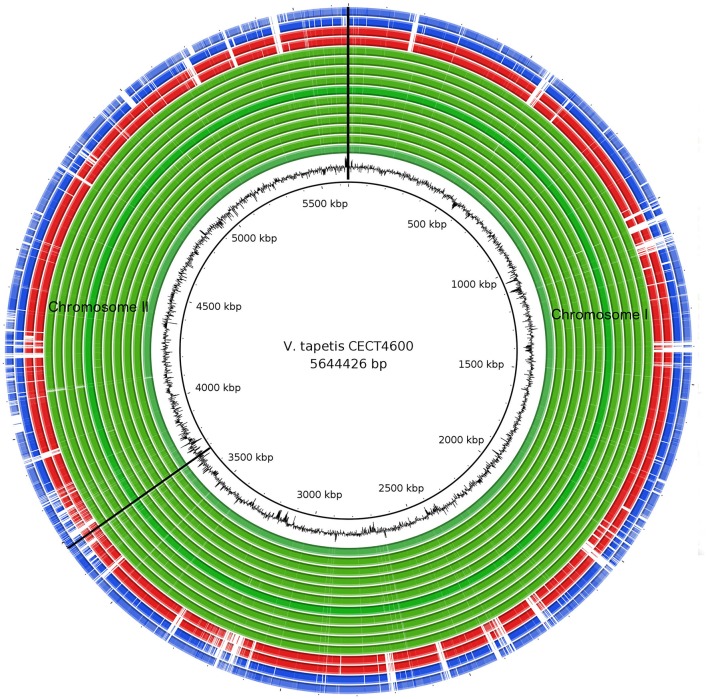
Comparison of V. tapetis genomes by blastn analysis. The inner most circle represents the reference genome V. tapetis CECT4600T. The second internal black circle represents the GC content. The green lanes represent genomes isolated from clams and native cockles before the year 1999 (IS1, IS5, IS7, IS8, IS9, P16B, RD0705, RP2.3, RP8.17, RP11.2, and UK6); red lanes, GDE and GTR-I strains isolated after 2000 from native clams Dosinia exoleta and Polititapes rhomboides, respectively; blue lanes, strains isolated after 1999 (HH6087, LP2) from fish (Hypoglossus hypoglossus, Symphodus melops). Genomic regions corresponding to the absence of genes in a given strain are in white.